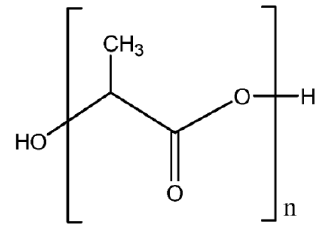
Figure 13. General structure of polylactic acid.